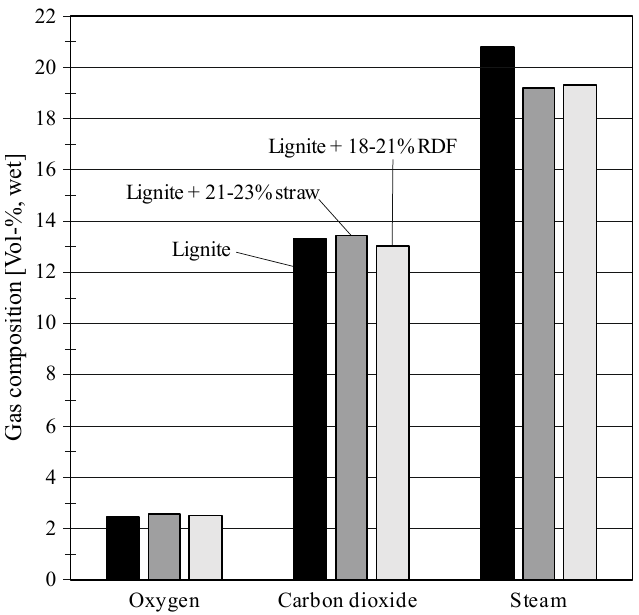
Figure 9. Flue gas composition during co-combustion (similar share of co-fuel).